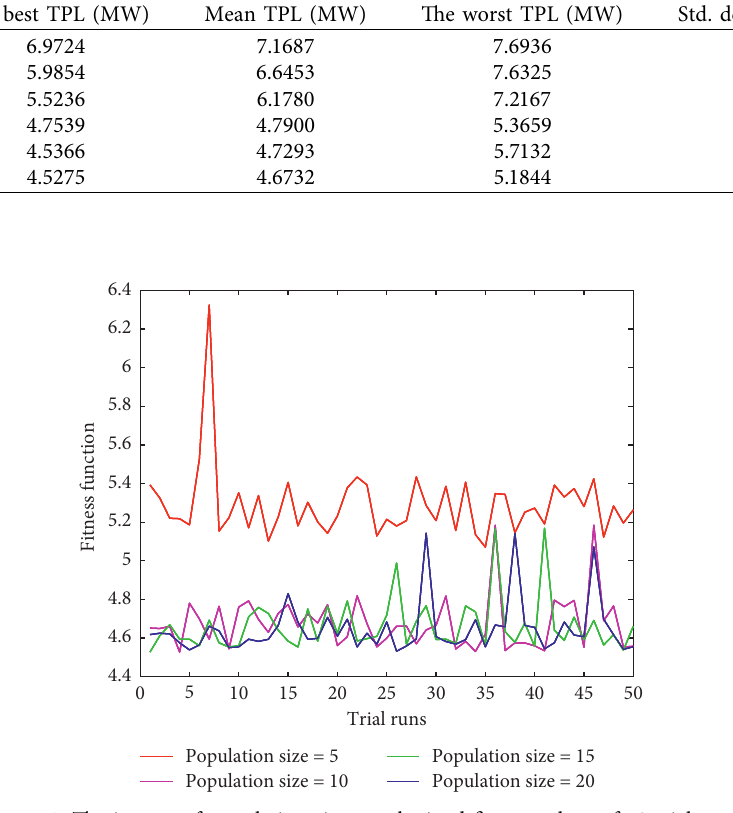
Table 3: Results obtained by setting different values to WF and fixing N Walk factor